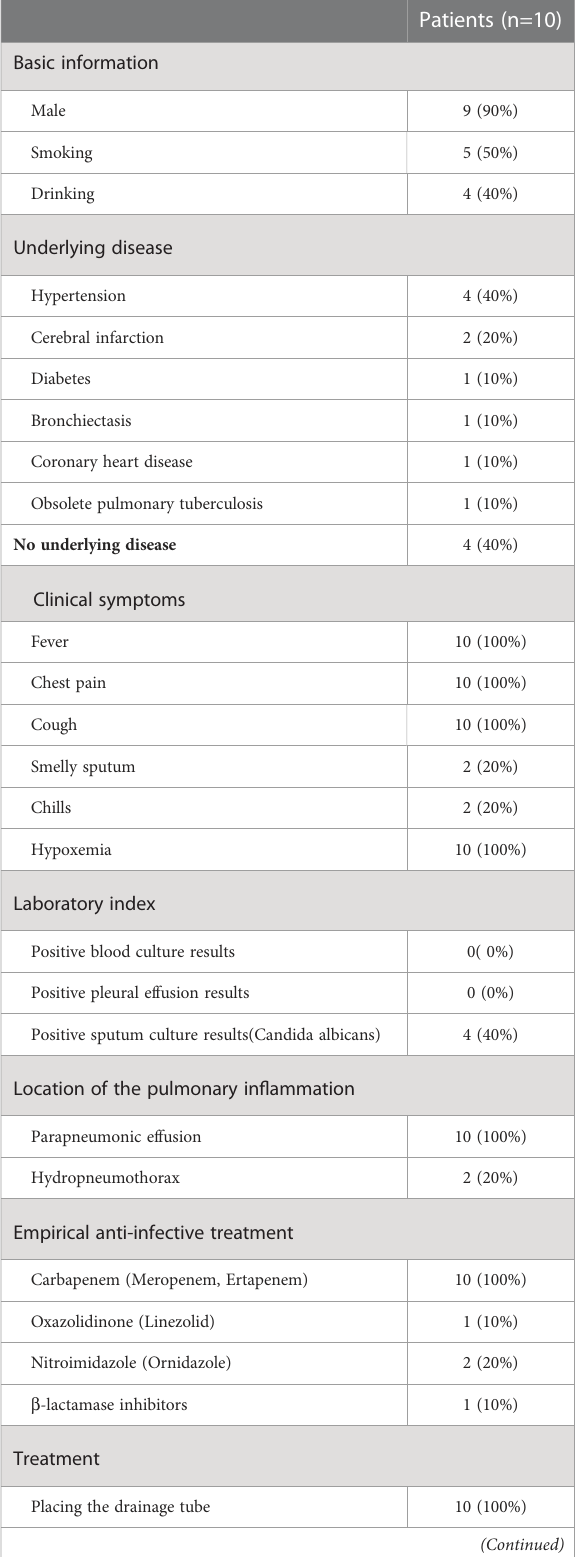
TABLE 1 Patients ’ characteristics upon